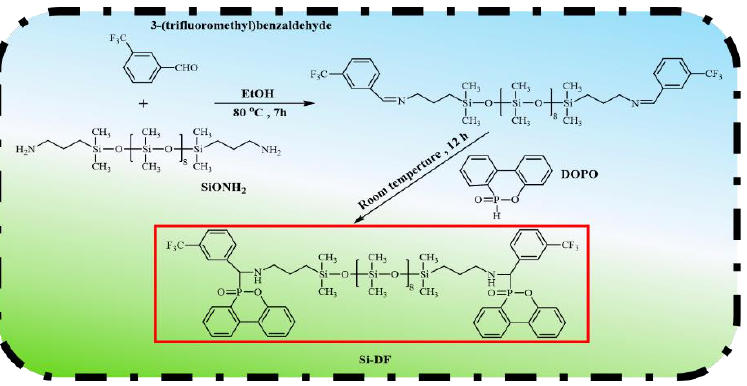
Figure 1. Synthesis route of Si-DF.